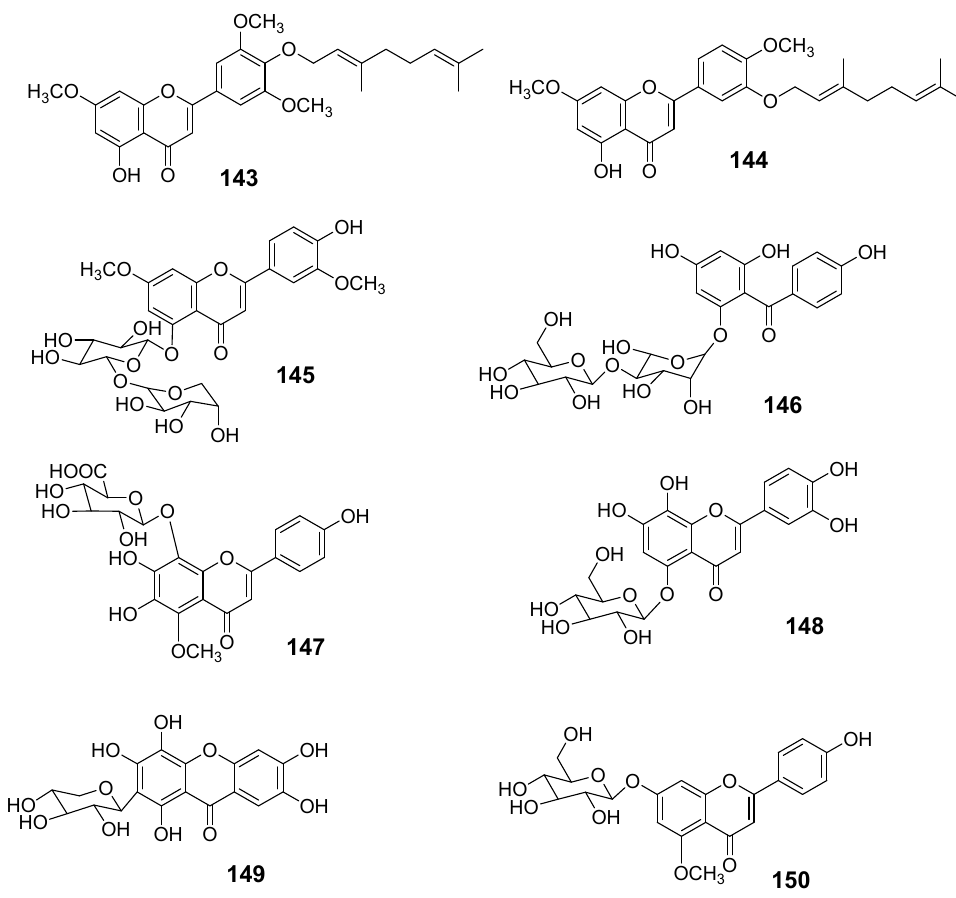
Figure 10. Structures of flavonoids from Aquilaria malaccensis.